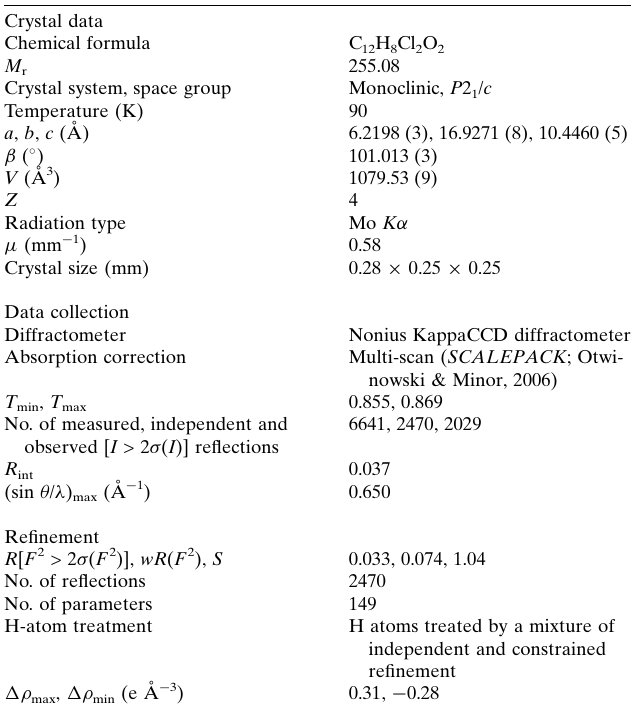
Table 2 Experimental details.